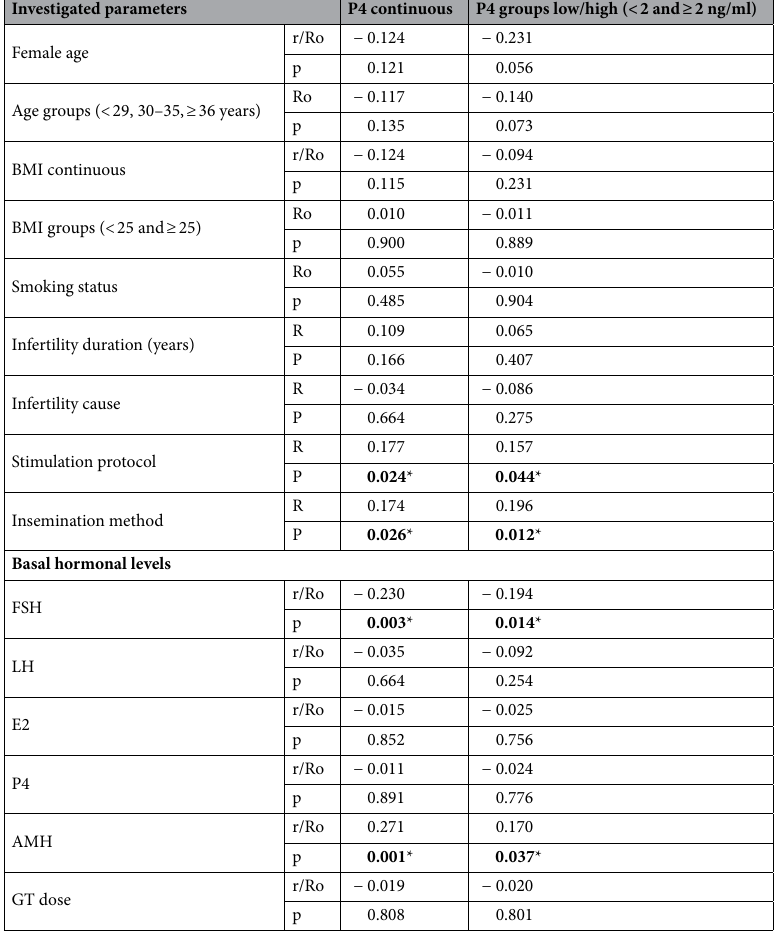
Table 3. Correlation of P4 on the OR day with patient and procedure characteristic and basal hormonal status. BMI body mass index, FSH follicle stimulating hormone, LH luteinizing hormone, E2 estradiol, P4 progesterone, AMH anti-Mullerian hormone, GT gonadotropins, ART assisted reproduction techniques. *p <